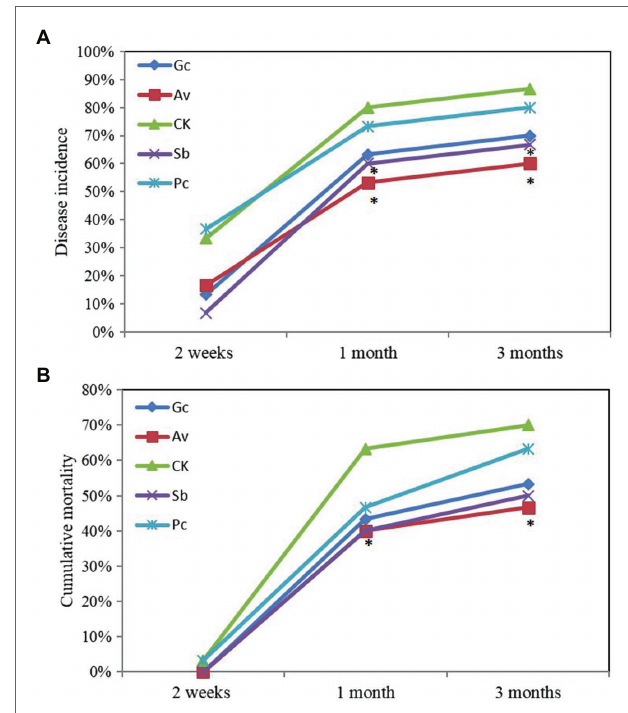
FIGURE 1 | Cumulative disease incidence (A) and mortality (B) of ECMF and DSE Pinus tabulaeformis seedlings after inoculated with PWN. Av and Sb represent P. tabulaeformis seedlings were inoculated with ECMF of Amanita vaginata and Suillus bovinus , respectively; Gc and Pc represent the P. tabulaeformis seedlings were inoculated with DSE of Gaeumannomyces cylindrosporus and Paraphoma chrysanthemicola , respectively; and CK as the control group. The asterisk represents p value < 0.05 using chi-square